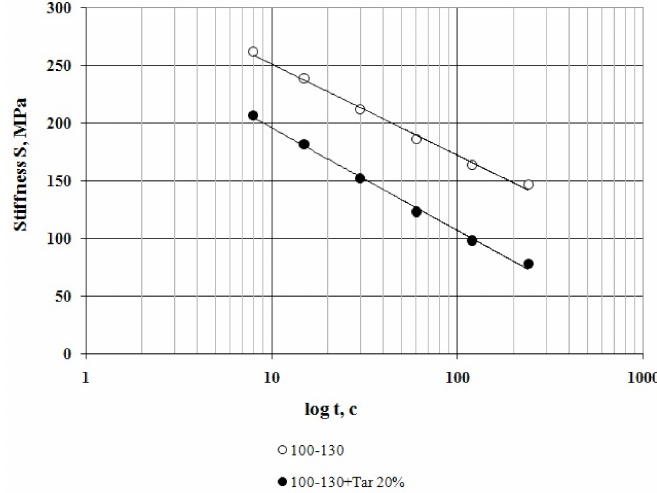
Figure 5. Stiffness variation of the virgin bitumen and the compounded one (20% of the tar) in time at the temperature of − 30 ◦